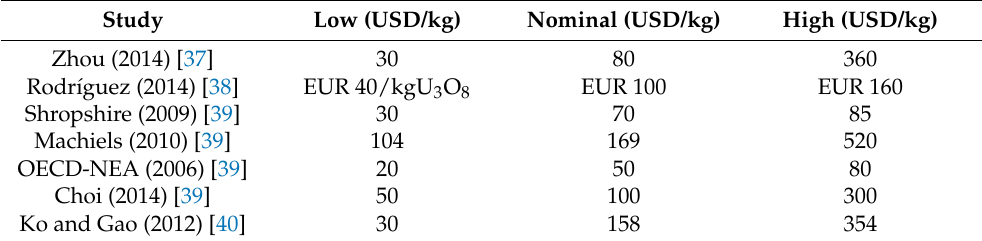
Table 1. Uranium prices used in economic studies of fuel cycle options.